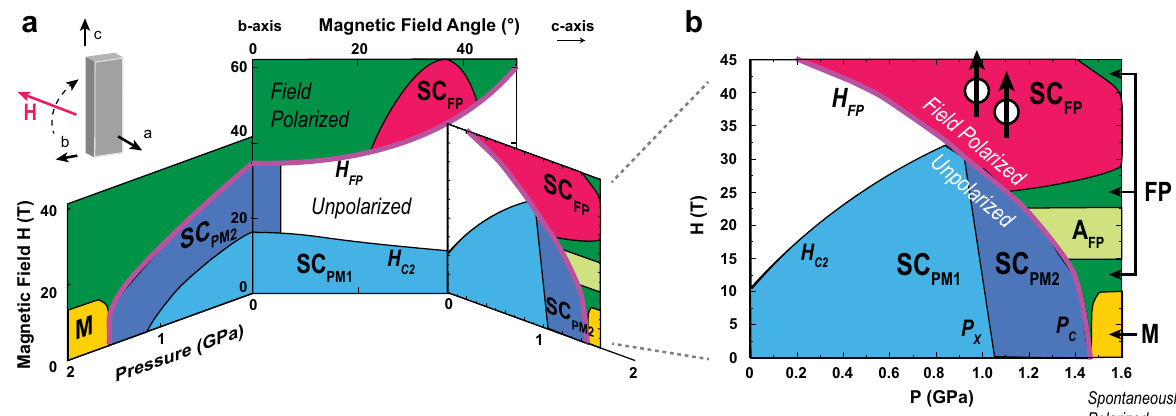
Fig. 1 The stability of superconducting and magnetic phases of UTe 2 . a The zero- fi eld superconducting phase SC PM1 exhibits a strongly direction-dependent upper critical fi eld H C2 . Along the crystallographic b axis, the reentrant superconducting phase SC PM2 is stabilized up to a fi eld fi rst-order magnetic transition at H FP , above which exists a magnetically polarized phase FP. Applied pressure uniformly suppresses all scales and H FP bounds superconductivity up to a critical pressure P c . b For a magnetic fi eld oriented between 25 and 30° between the b - and c axes, the high- fi eld reentrant superconductivity SC FP stabilizes in the FP phase. Applied pressure enhances SC PM1 , which meets a decreasing H FP at a crossover region P x . Here, SC PM1 transitions to SC PM2 , which survives up to P c , where it is replaced by magnetic order M. Below P x , H FP is a lower bound on SC FP , but above P x , the two are decoupled and SC FP survives beyond P c . An anomaly A FP , suggestive of Landau-level superconductivity, emerges above P c . The phase diagram is based on the resistance data shown in Fig. phase has a two-component order parameter while the order parameter of SC PM2 phase only has one component 11 . Our